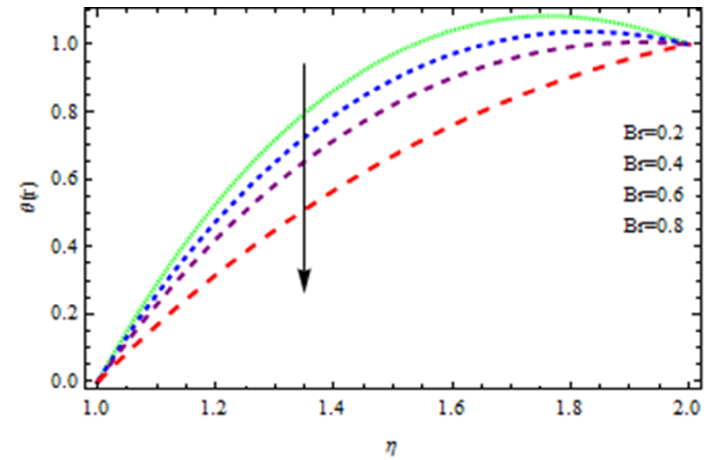
Figure 13. Influence of Br on the temperature curve.